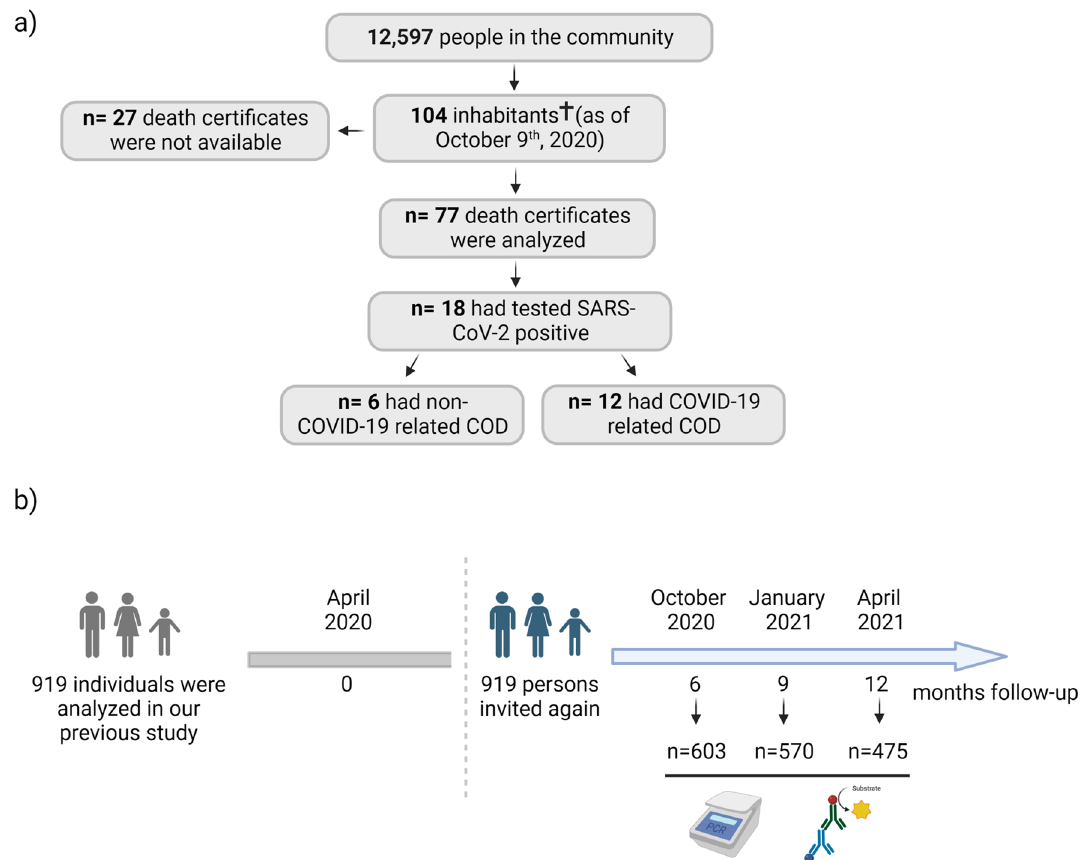
Figure 1. Illustrations depicting the number of decedents for death certificate assessment and study participants for seroprevalence survey. ( a ) Between March and October 2020, a total of 104 inhabitants of the studied community died, according to information we obtained from the state office for information and technology in North Rhine-Westphalia (Germany). The death certificates of 77 subjects were screened for information about gender, date of birth, date of death, COD, comorbidities, and history of SARS-CoV-2 infection. ( b ) Enrollment and flow of participants through the study as well as experimental procedures. In total 919 study participants from our previous 7-day seroepidemiological observational study 21 were asked again to participate in at least one of the three follow-up visits (October 2020, January 2021, and April 2021). The only inclusion criterion was enrollment and sampling in our previous study (April 2020). Illustrations were created with bioRender.com premium (publication license